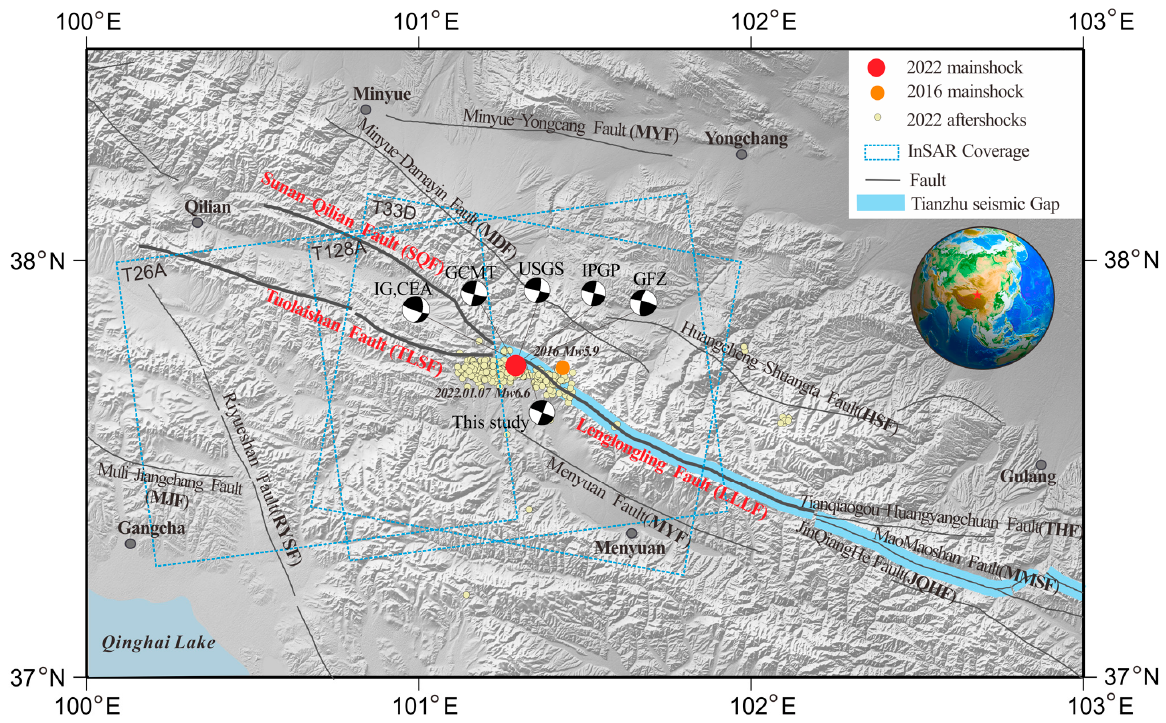
Figure 1. Active faults and seismotectonic background of the region surrounding the 2022 Menyuan earthquake. The red dot represents the 2022 Menyuan earthquake, and the faults are referred from [6,10,11]. The yellow points indicate the aftershocks [12].